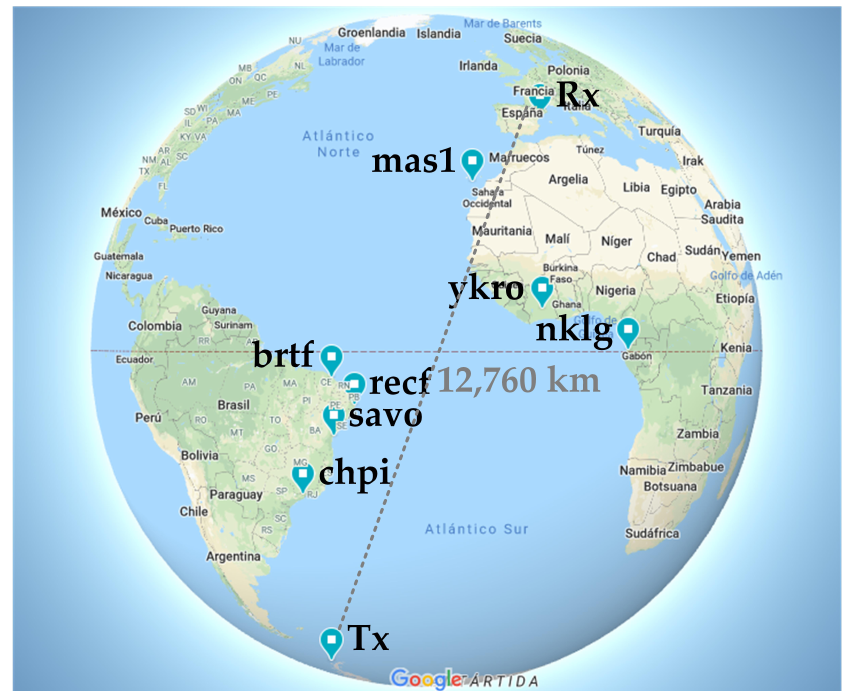
Figure 1. Geographical link characteristics. The transmitter (Tx) is located in the Spanish Antarctic Station (SAS), Livingston Island, and the receiver (Rx) is placed in Cambrils, Spain. Furthermore, the Global Navigation Satellite System (GNSS) receivers of the International GNSS System (IGS) used to detect the irregularities associated with the equatorial plasma bubbles (EPB) are shown: mas1 (27.61 ◦ N, 15.63 ◦ W); nklg (0.35 ◦ N, 9.67 ◦ E); ykro (6.83 ◦ N, 5.24 ◦ W); brtf (3.85 ◦ S, 38.43 ◦ W); chpi (22.55 ◦ S, 44.98 ◦ W); recf (8.00 ◦ S, 34.95 ◦ W); and savo (12.86 ◦ S, 38.43 ◦